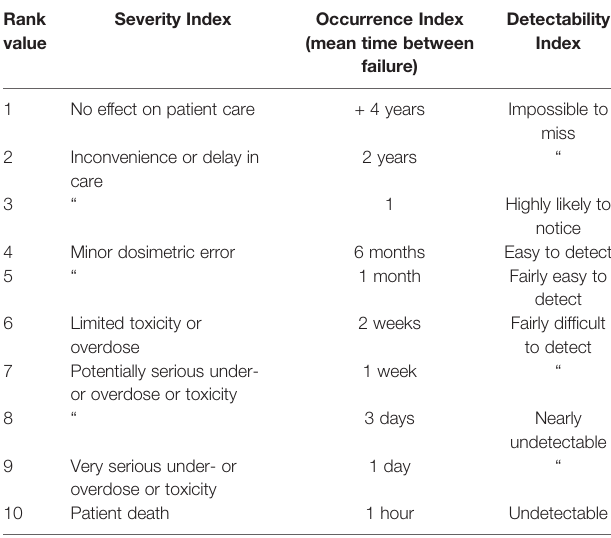
TABLE 1 | Numerical scale used to assign rank values to Severity Index, Occurrence Index, and Detectability Index for each